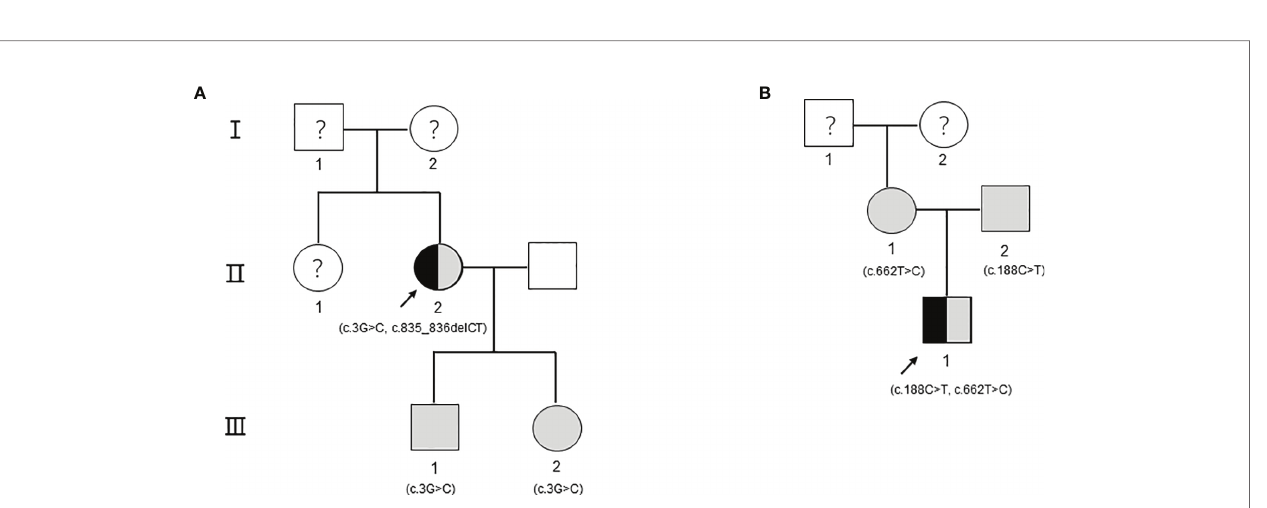
FIGURE 2 | The pedigree including the patients. The arrow refers to the proband. Black indicates that the person has type I hyperlipoproteinemia. The shading indicates that the person carries gene mutations but has a healthy phenotype. Circles indicate female individuals reared, and squares indicate male individuals reared. The question mark means that it cannot be determined whether the individual carries a genetic mutation. (A) The pedigree of patient 1. (B) The pedigree of patient